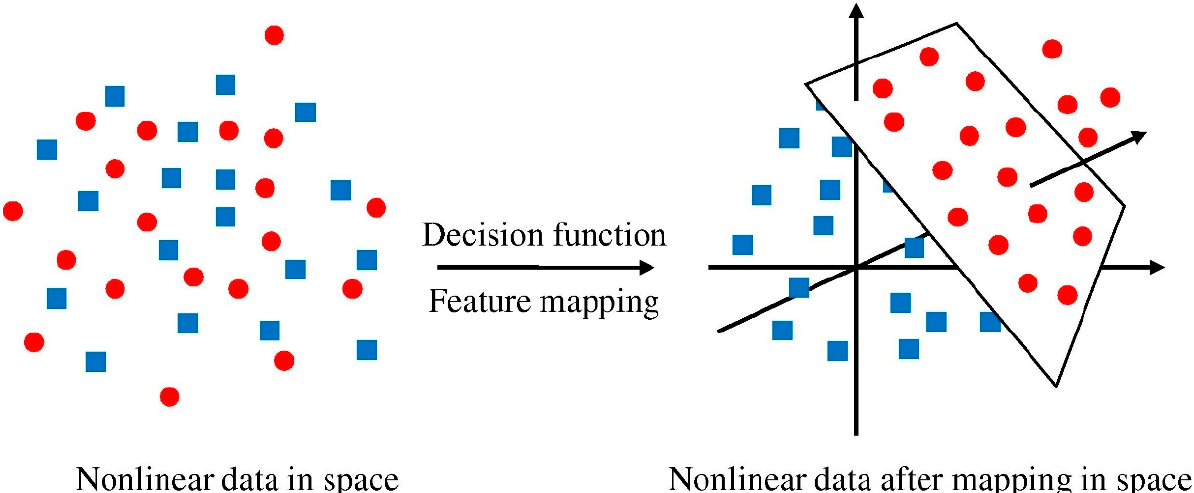
Figure 3. Support vector machine model mapping. Reprinted/adapted with permission from [60].